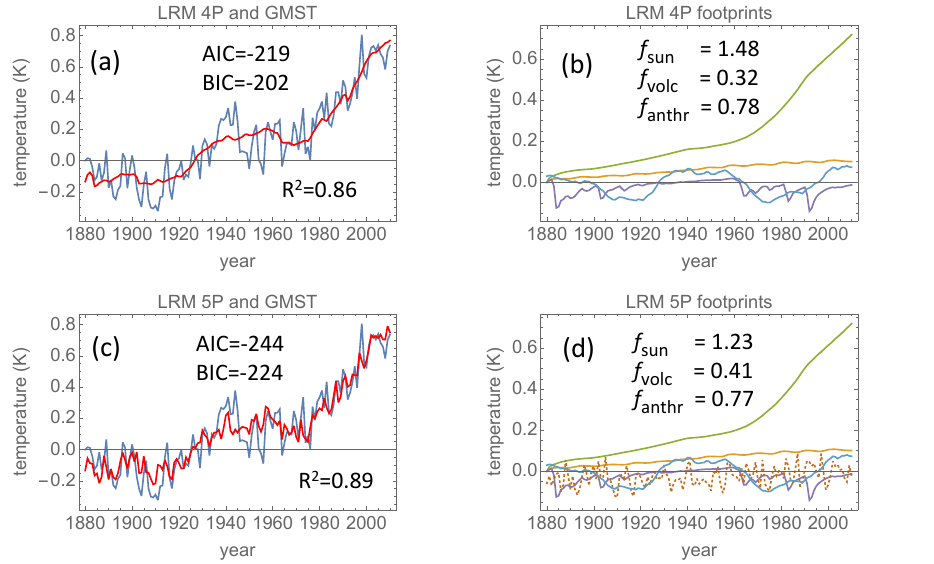
Figure 5. Panel (a) : the LRM 4PA signal, i.e., the regressed signal according to Eq. (1) including the three forcings and AMO (but not ENSO) as predictors. Panel (b) : the footprints f sun S ( t ) (yellow), f volc V ( t ) (magenta), f anthr H ( t ) (green), and f AMO A ( t ) of LRM 4PA regressed signal. Panel (c) : the LRM 5P signal, i.e., the same as in (a) , but with the ENSO signal added in the regression. Panel (d) : the LRM 5P footprints, i.e., the same as in (b) , but with the ENSO signal added in the regression. The ENSO footprint is the orange dotted curve.